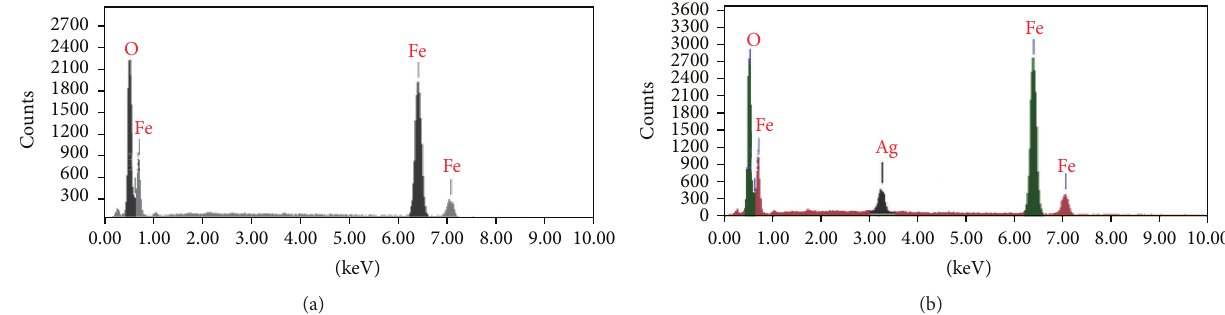
Figure 5: EDAX of (a) Fe 3 O 4 nanoparticles and (b) Ag-doped Fe 3 O 4 nanoparticles.